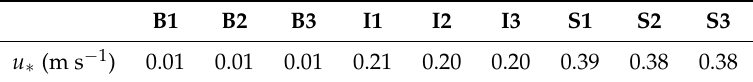
Table 2. The friction velocity ( u ∗ ) at the end of the 6-h simulation.